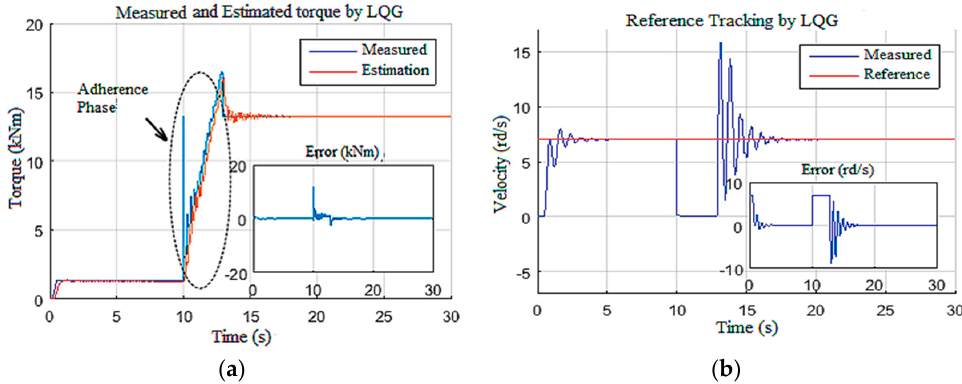
Figure 21. LQG observer-based controller responses: ( a ) Tob; ( b ) bit velocity.